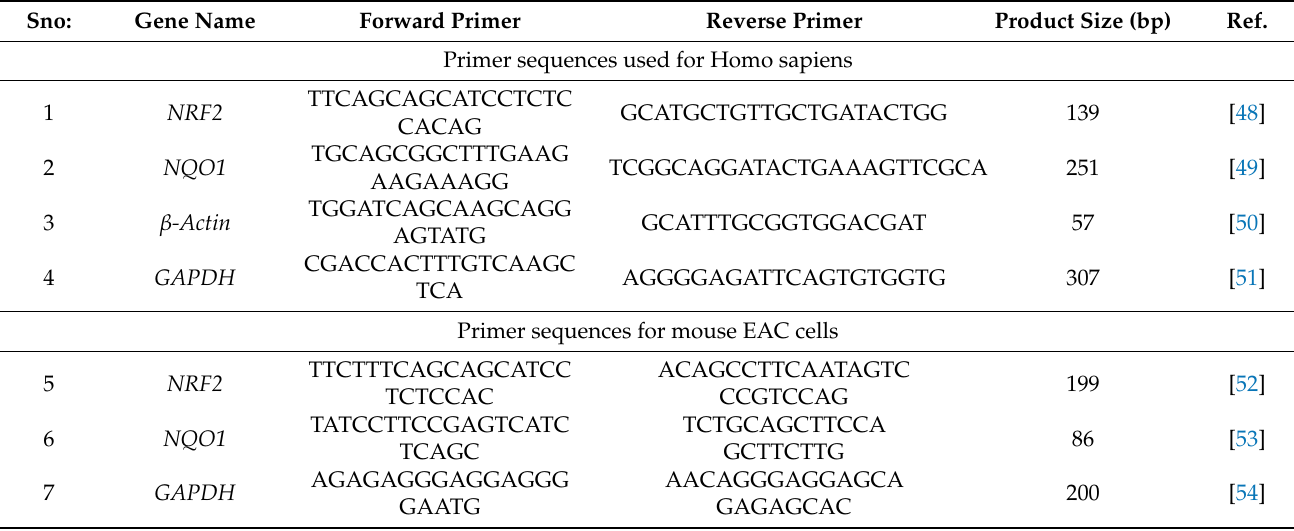
Table 1. Used primer sequences